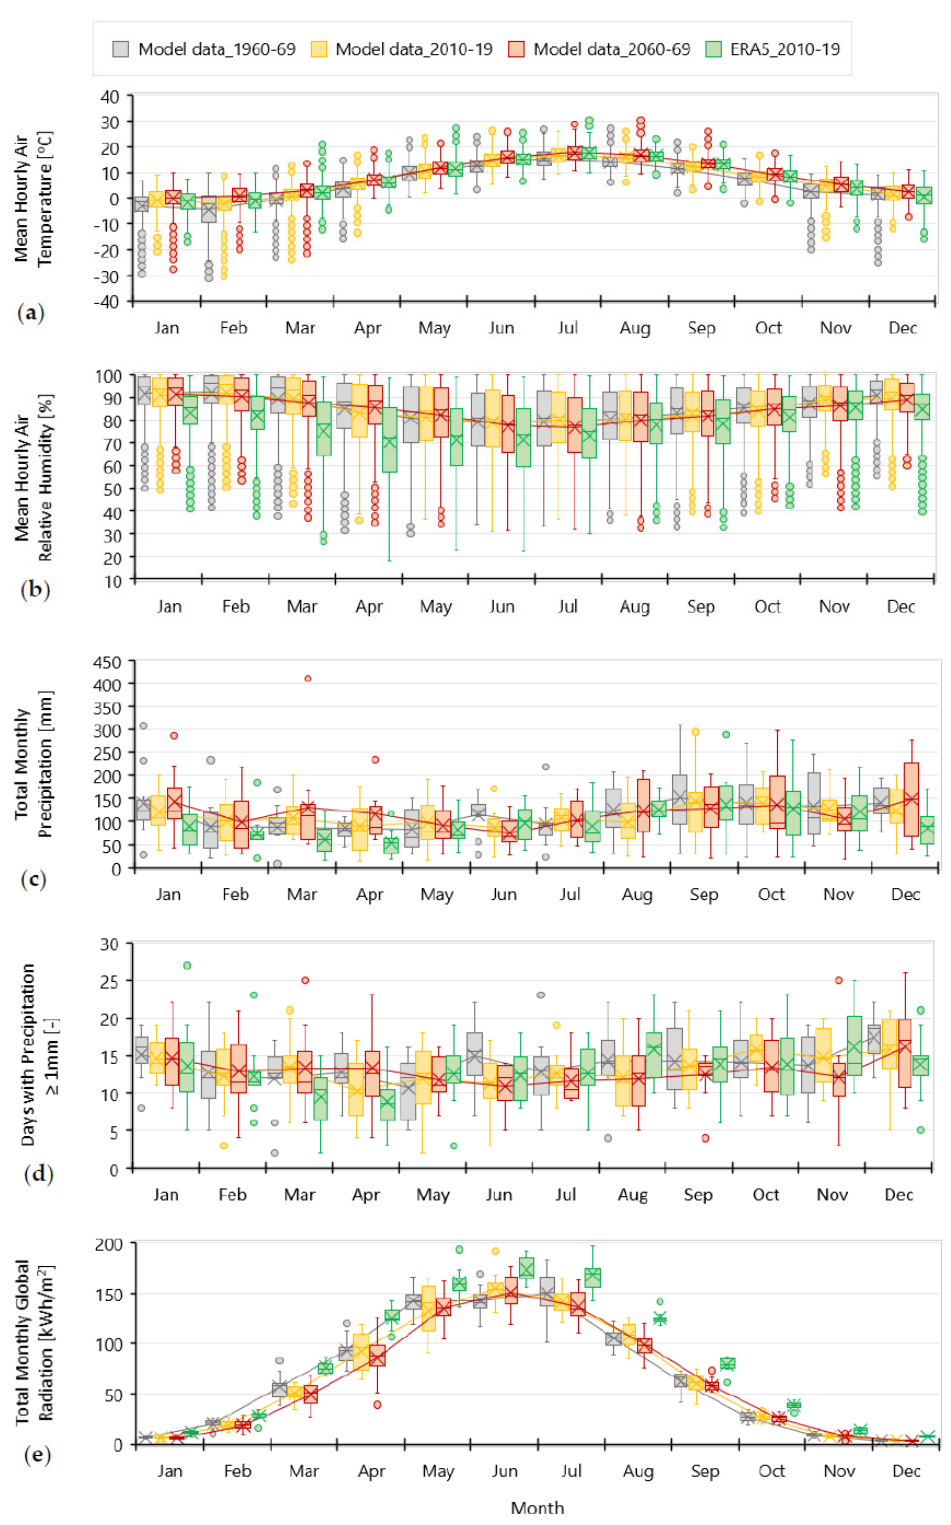
Figure 12. Comparison among ( a ) air temperature, ( b ) air relative humidity, ( c , d ) precipitation and ( e ) radiation data derived from the MPI-ESM-LR_REMO2015 model and ERA5 reanalysis. In the boxplots the box shows 50% of the data, with median represented as a horizontal bar and the average value highlighted with the ‘x’ symbol. The whisker extends to two standard deviations of the data and the circles represent the outliers.